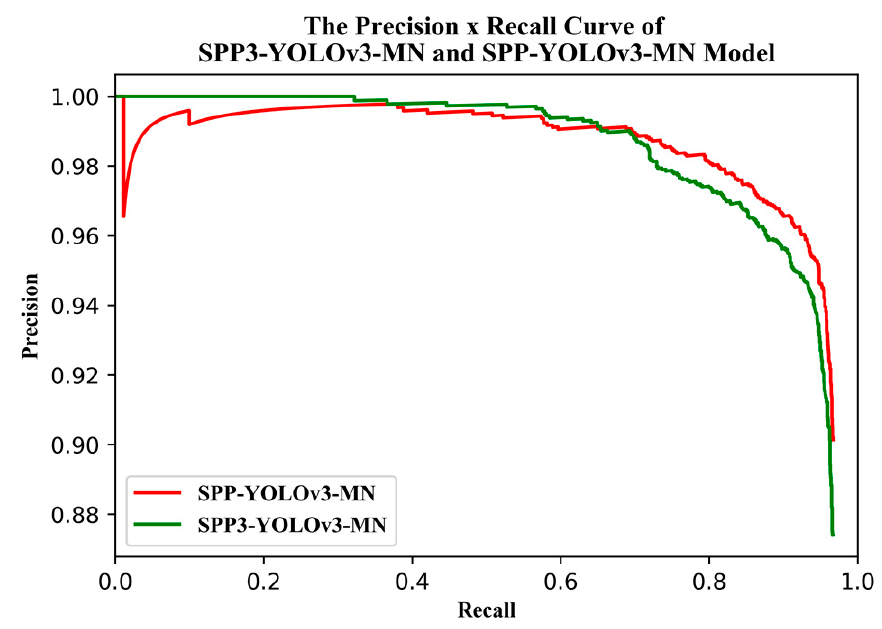
Figure 18. PR curve of the SPP3-YOLOv3-MN and SPP-YOLOv3-MN models.